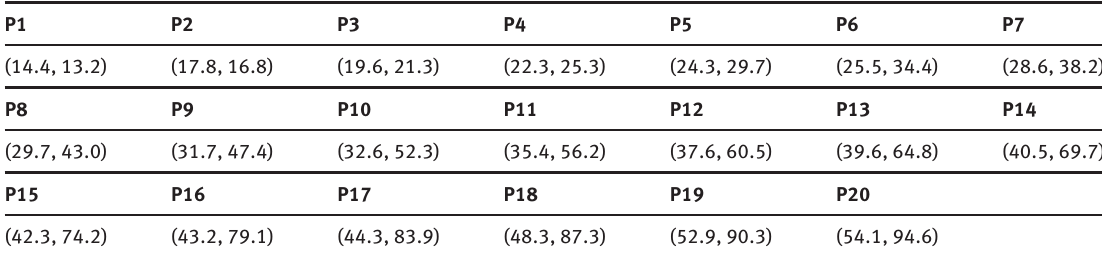
Table 13. The Coordinates of UCAV Flying